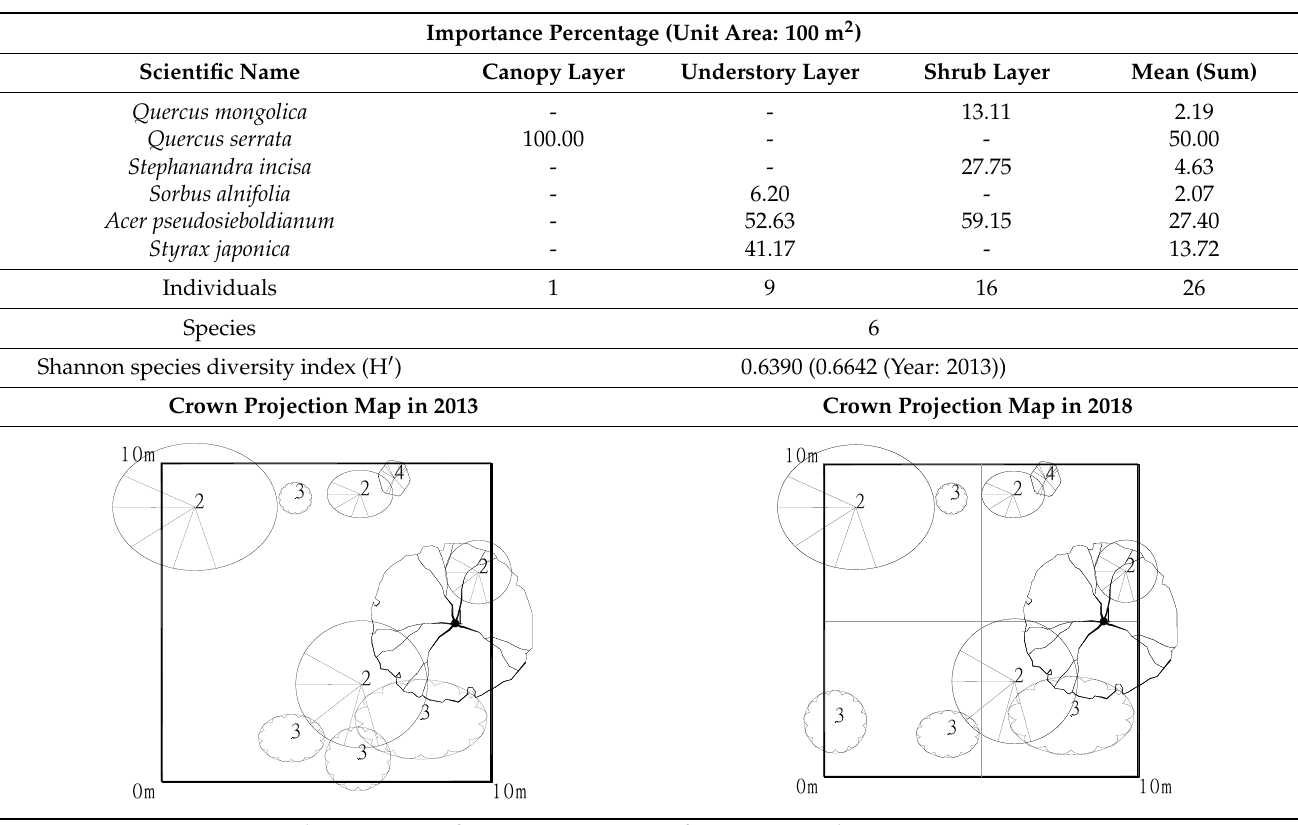
Figure 3. Tree age and growth of the Quercus serrata sample tree in fixed survey plot no. 7 in the forest of the Changdeokgung Rear Garden. Black line in the figure shows the annual rings of the late